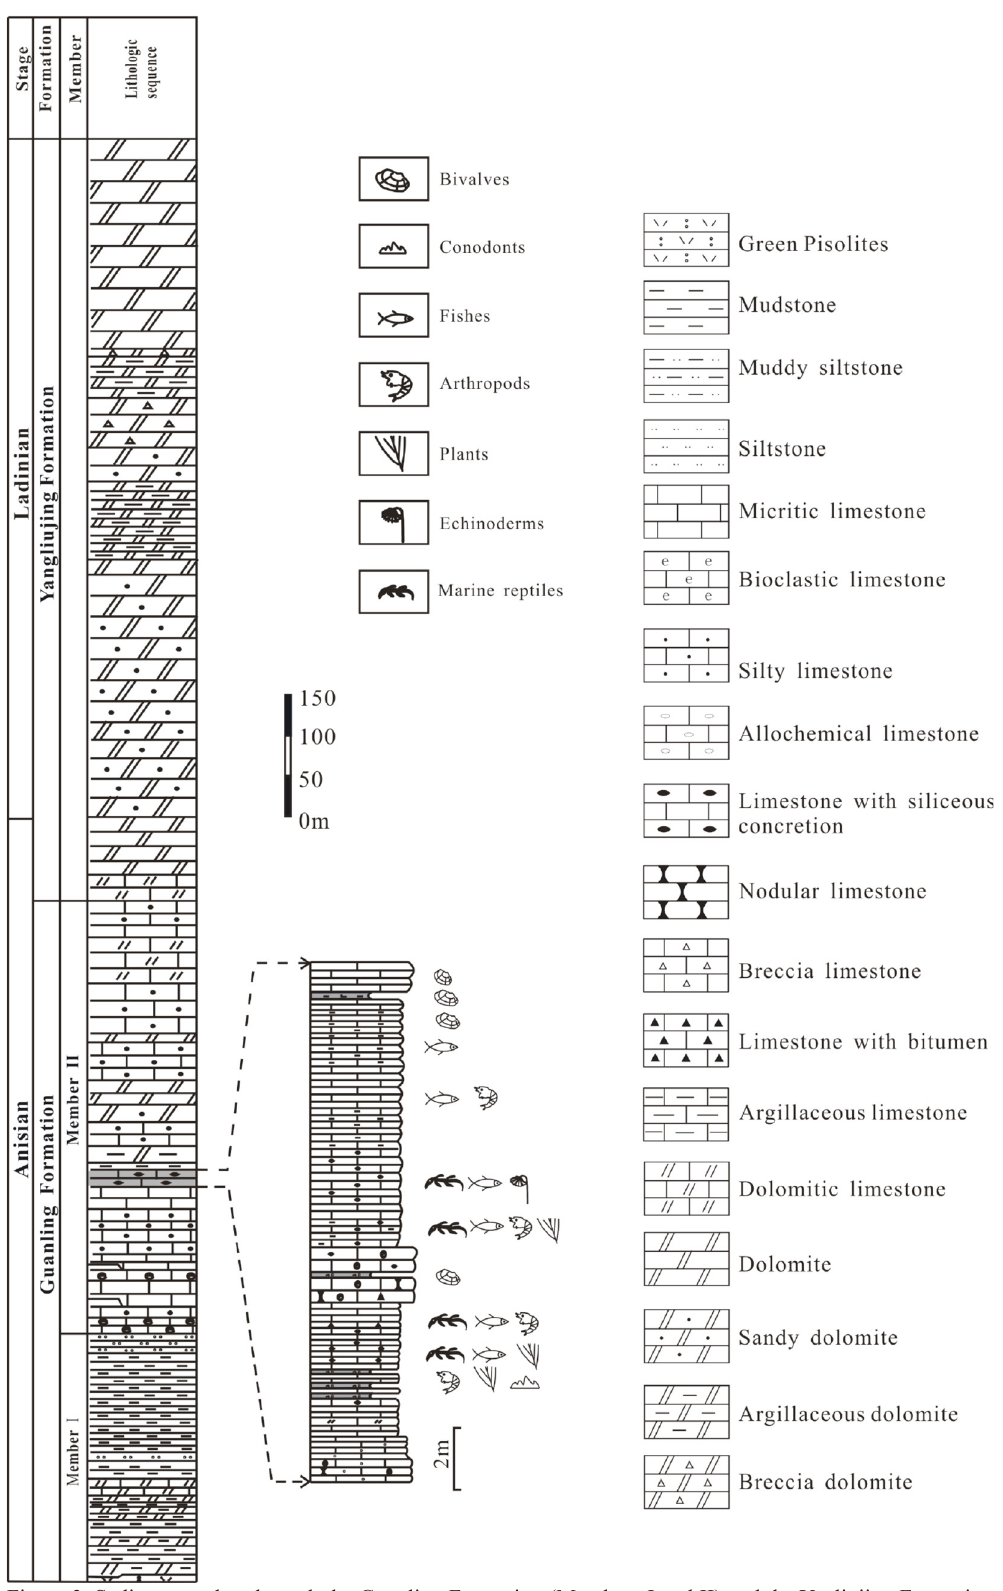
Figure 3. Sedimentary log through the Guanling Formation (Members I and II) and the Yanliujing Formation at the Shangshikan locality, near Daaozi village, Luoping county, Yunnan province, showing lithologies, sedi- mentary structures and key fossiliferous beds. Modified from Zhang et al .